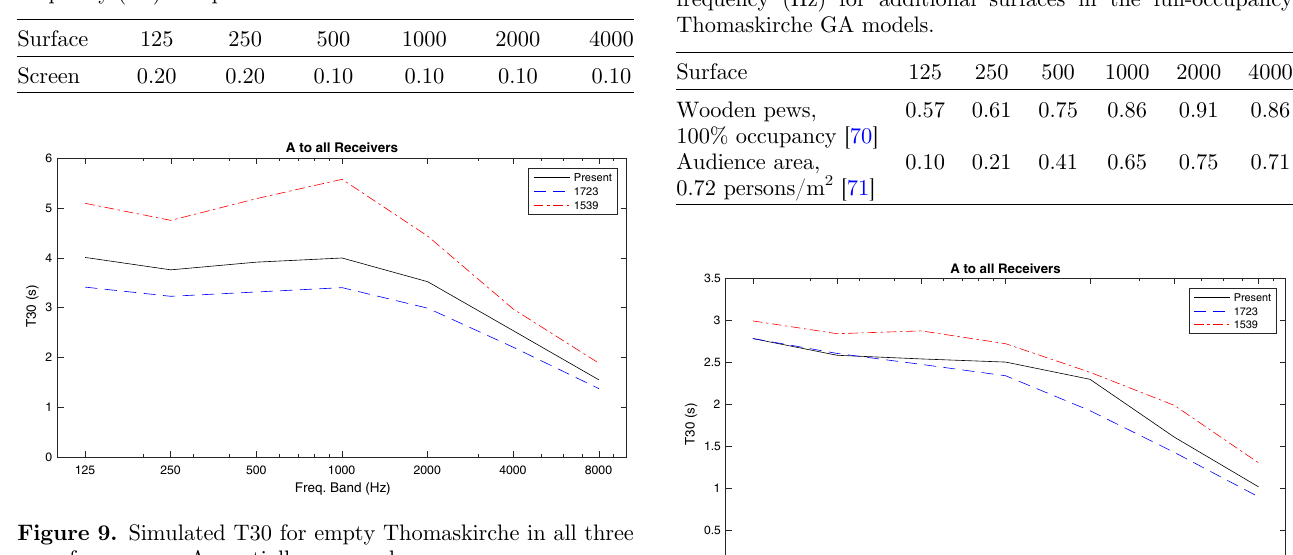
Table 5. Sound transmission coef fi cients by octave band center frequency (Hz) for speci fi ed surfaces in the 1539 model.